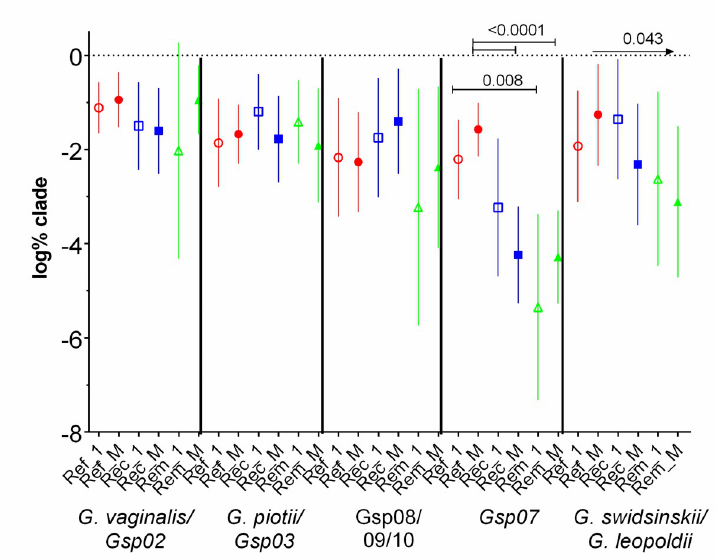
Fig 2. Association of abundance of Gsp07 and G . swidsinskii/G . leopoldii with poor clinical response to metronidazole. Abundance of all species of Gardnerella were determined at enrollment (1, open symbols) and as mean abundance of days 7–14 (M, closed symbols), per patient of clades by clinical outcome group. Ref = Refractory patients, Rec = Recurrent patients, Rem = Remission patients. Means and 95% CI’s are depicted. Comparing like days between outcome groups by ANOVA post-hoc Holm-Sidak, showed significant differences among Gsp07 abundance (only significant P values are shown); the arrow for G . swidsinskii/G . leopoldii comparisons indicates a significant downward trend. Paired t-tests for all 15 day 1 versus mean abundance of all clades showed no significant time- dependent changes.